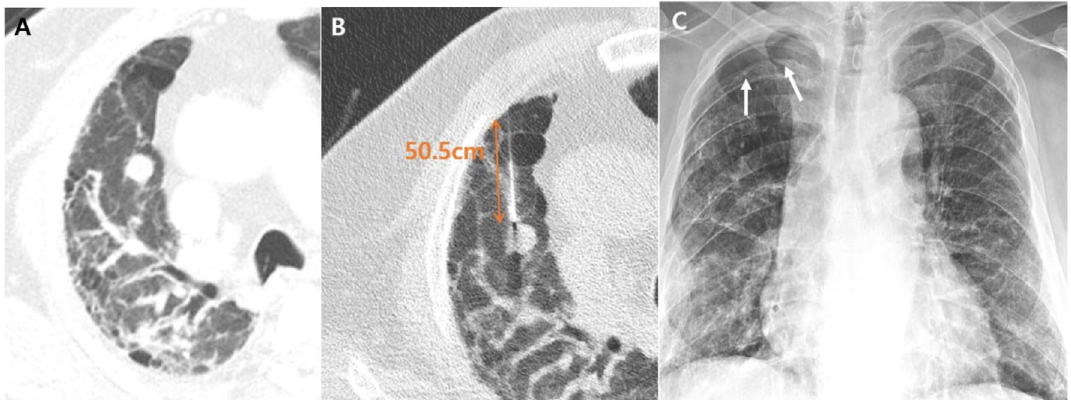
Figure 2. A 69-year-old male patient with idiopathic pulmonary fibrosis. The patient showed a 1.4-cm nodule in his right upper lobe ( A ). CT-guided percutaneous core needle biopsy (PCNB) was performed with the patient in the supine position. The length of the needle path (pleura to lesion) was 5.1 cm ( B ). Small cell carcinoma was confirmed through PCNB. He presented with pneumothorax after PCNB on follow-up radiography ( C ).